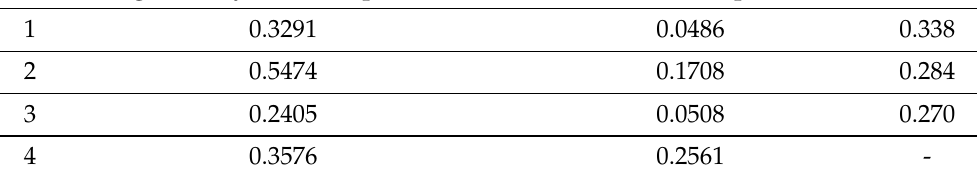
Table 2. RMS errors between simulated and measured quantities for the four